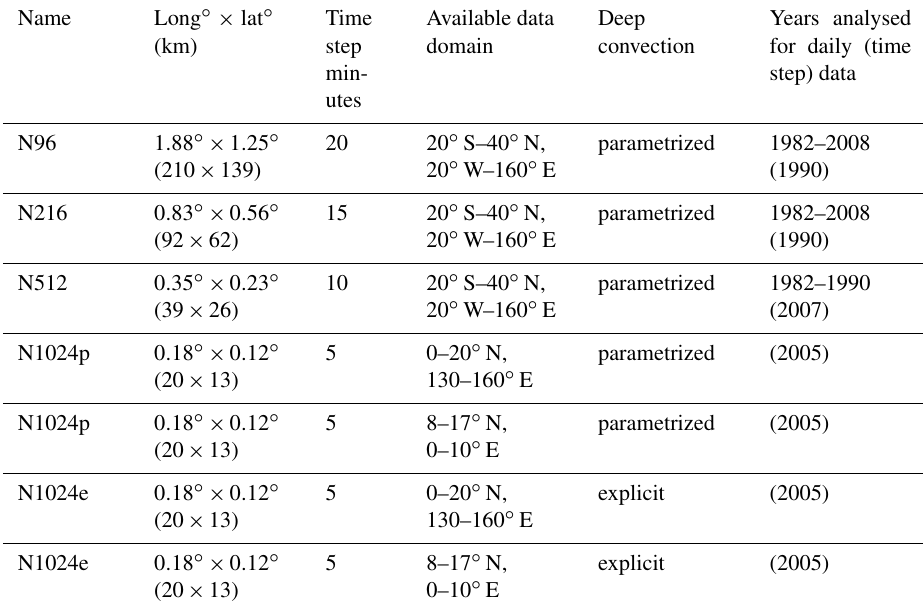
Table 1. For each MetUM-GA6.0 simulation: the name of the simulation, the horizontal resolution in degrees (to the nearest 0.01 ◦ ) and the equivalent in kilometres at the Equator, the time step, the largest domain over which data were extracted, the representation of deep convection (either a sub-gridscale parametrization or entirely “explicit” convection) and the years of daily (time step) data analysed. Note that data are limited to June, July, August, and September of any given year. Models are listed in order of decreasing horizontal grid spacing, as in the